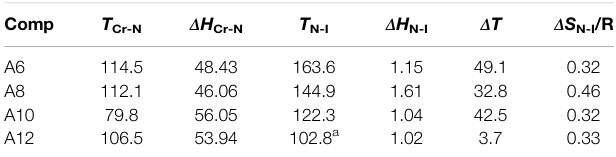
TABLE 1 | Temperatures of mesomorphic transitions, ° C (enthalpy Δ H , kJ/mole), mesophaserange( Δ T , ° C),andthenormalized-entropy, Δ S /R,oftransitionfor investigated series An .